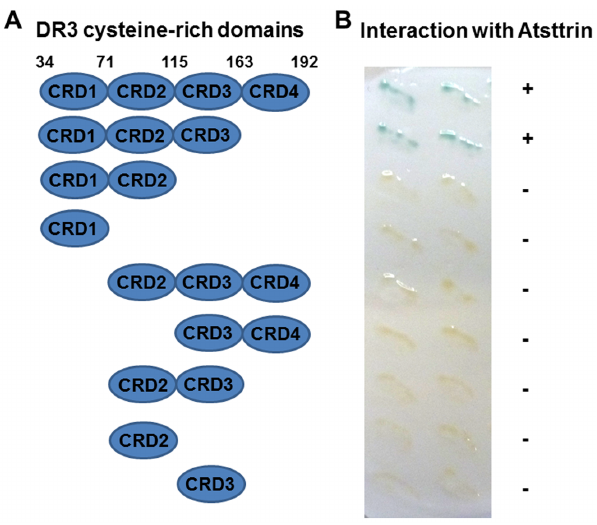
Figure 3. The first three CRDs of DR3 extracellular portion are required for binding to Atsttrin. A . Schematic diagram of deletion constructs of DR3 extracellular portion used to map those fragments that bind to Atsttrin. Numbers refer to amino acid residues in the DR3. Interactions between Atsttrin and DR3 derivatives are summarized and indicated by ‘‘ + ’’ or ‘‘ 2 ’’. B . b -Galactosidase activity was used to test interaction between various compositions of extracellular domains of DR3, as indicated, and Atsttrin. Two independent yeast transformants for each pair of plasmids were transferred onto a nitrocellulose membrane and the b -galactosidase activity was determined.